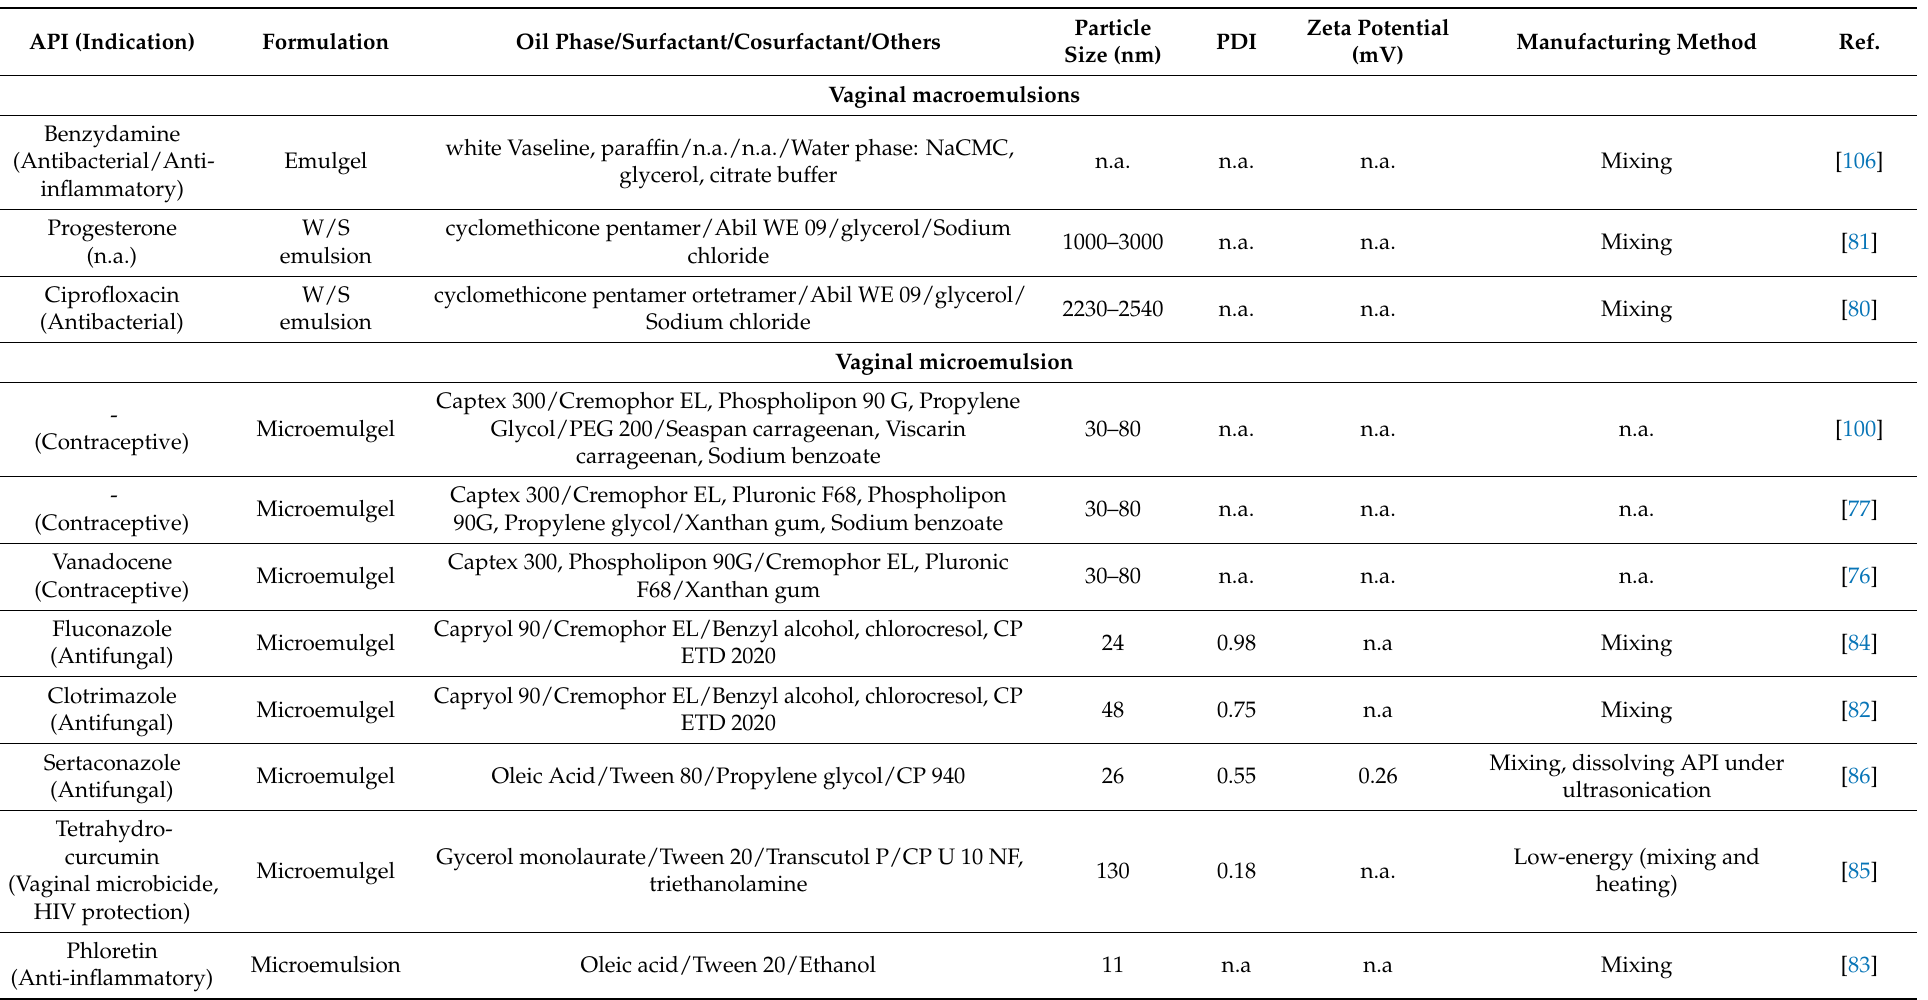
Table 4. Vaginal macroemulsions, microemulsion- and nano-emulsion-based dosage forms—composition, characteristic properties and manufacturing